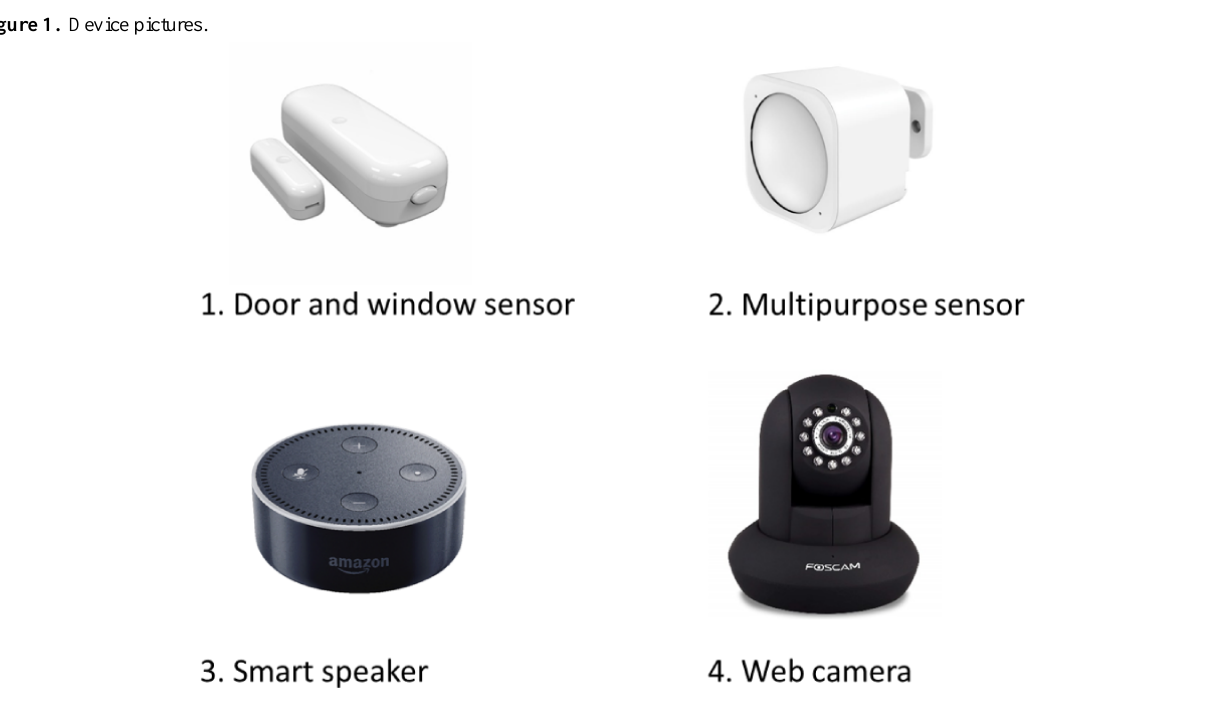
Figure 1. Device